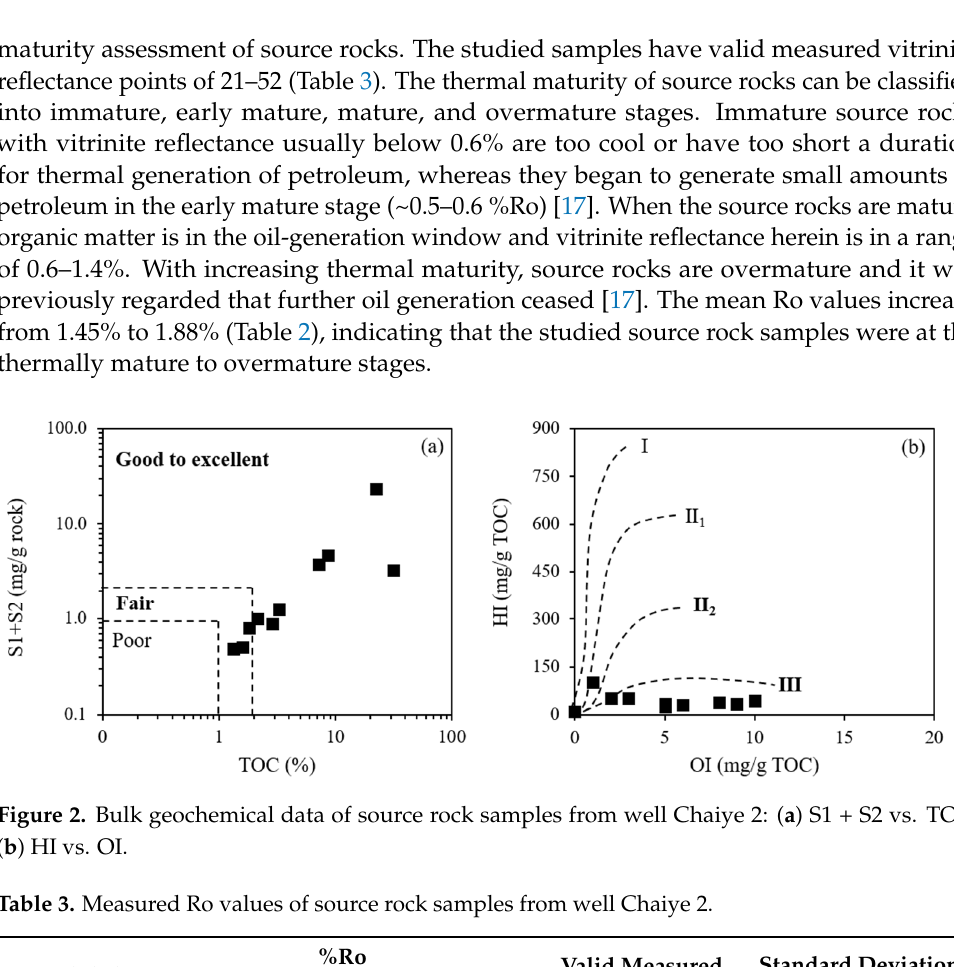
Table 2. Results of Rock-Eval pyrolysis and Soxhlet extraction of Chaiye 2 rock samples.